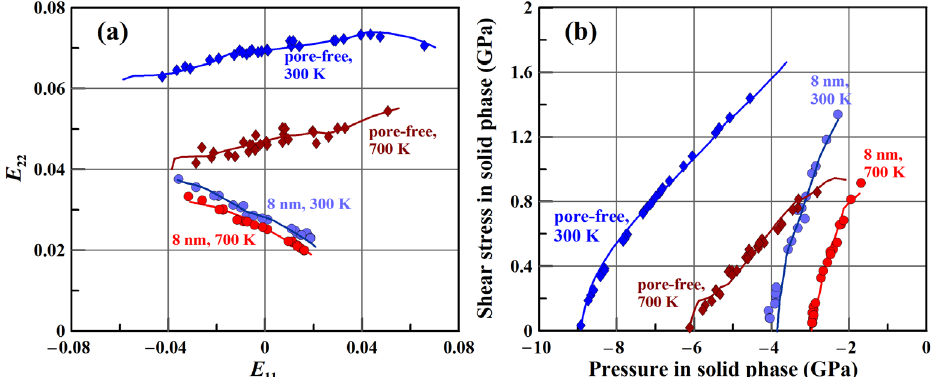
Figure 8. Threshold of dislocation nucleation at tension of pore-free aluminum and nanoporous aluminum with 8 nm spherical pores at different temperatures (300 K and 700 K). Symbols showing MD data and lines showing the ANN-based prediction for the nucleation threshold are plotted ( a ) in the deformation space { E 11 , E 22 } and ( b ) as the dependencies of the critical shear stress in the solid phase on the pressure in the solid phase.